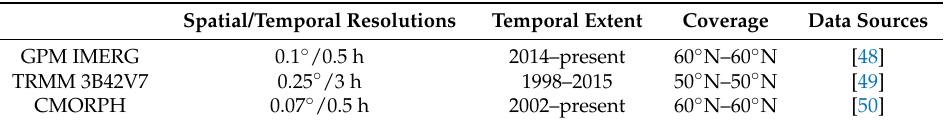
Table 1. The satellite precipitation products used in this